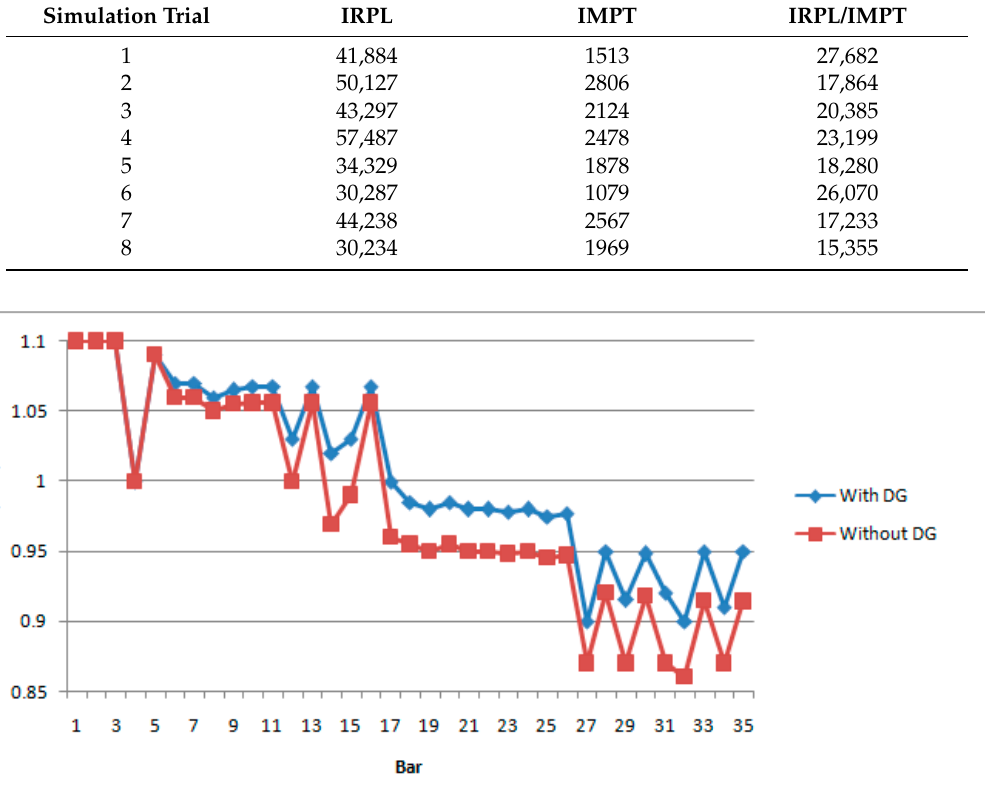
Figure 4. Voltage profile system of 34 bars with and without DG. Energies 2017 , 10 , 960